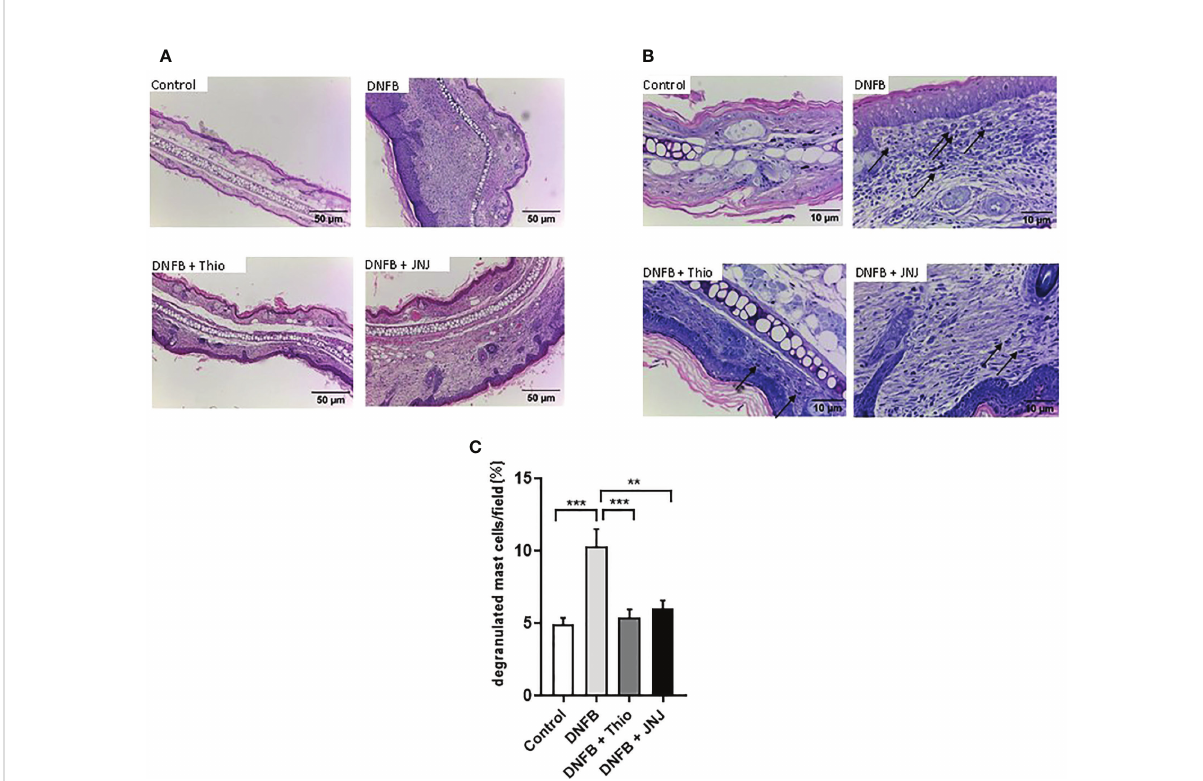
FIGURE 2 (A) Microscopic analysis of topical tissue stained with hematoxylin and eosin (×10 magni fi cation). (B) Degranulated mast cells stained with Giemsa are indicated by arrows (×40 magni fi cation). Representative micrographs of three independent experiments are shown. (C) Degranulated mast cells in tissue sections of the ear were counted in four fi elds chosen at random. Data are presented as the mean ± SEM of three independent experiments using three mice. ** p < 0.005; *** p <